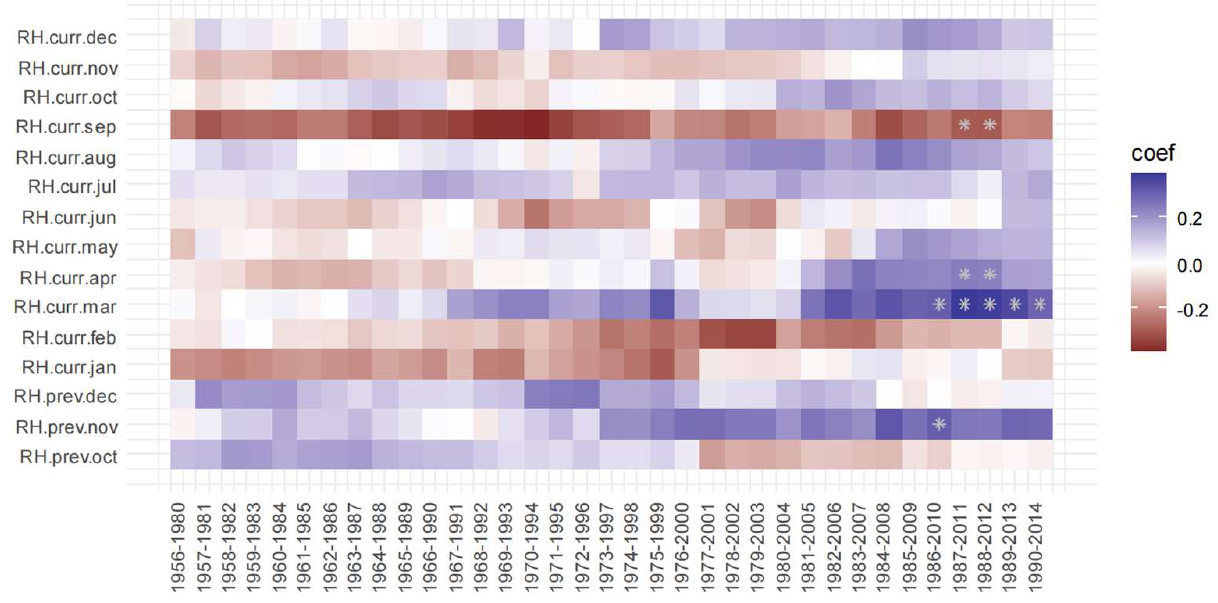
Figure 5. Moving correlation coefficients between tree-ring chronology and sunshine duration; prev. and curr. indicate previous and current years; * indicates significance at 0.05 level.